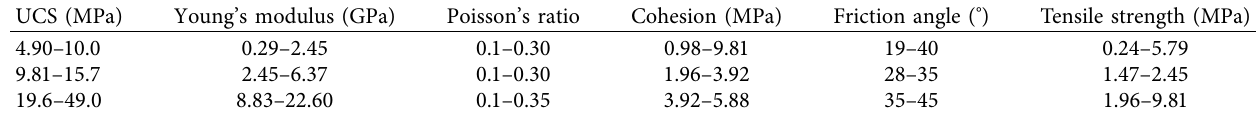
Figure 3: Numerical model of coal specimen and the uniaxial compressive boundary condition. Table 3: Empirical parameters initially used in the numerical simulation